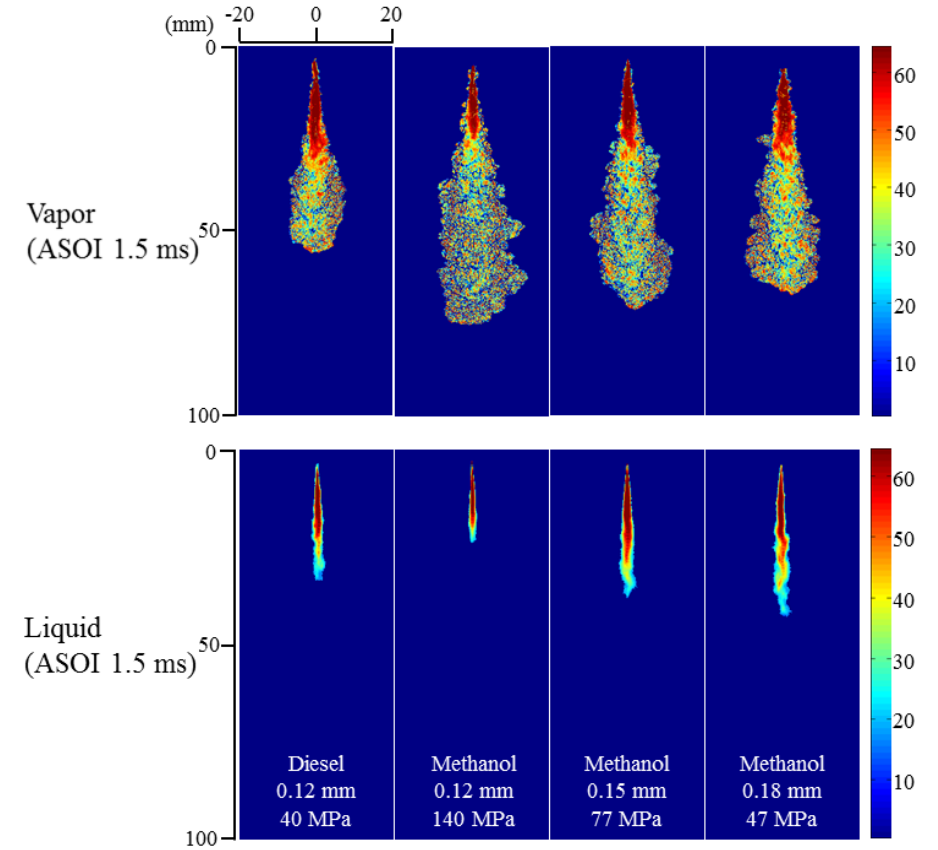
Figure 13. Comparison results of typical evaporating spray images under different strategies. The time-resolved spray parameters are quantitively plotted in Figure 14. The high pressure or the large nozzle hole makes the spray tip penetration, spray angle and spray area of the vapor phase methanol spray significantly larger than those of the diesel spray at the same timing during the same injection duration. When the hole diameter is 0.12 mm, since the injection volume of methanol is more than twice that of diesel, in order to ensure the same injection duration, the injection pressure of methanol should be increased to 140 MPa, and the spray penetration is about 20 mm longer than that of the diesel spray. With the decrease in injection pressure, the methanol spray penetrates a shorter distance. When the nozzle hole diameter of methanol is 0.18 mm, the injection pressure can be comparable to that of diesel. However, since the cross-sectional area of the nozzle hole of methanol is more than twice that of diesel, the spray penetration distance is still longer than that of diesel by about 15 mm. From the perspective of the methanol spray alone, with the decrease in the injection pressure, the spray penetration should decrease, but the momentum loss is not so great due to the increase in the nozzle hole diameter. As a result, the final spray tip penetration does not drop by much. With the decrease in injection pressure, the spray angle of methanol is apparently decreased. However, affected by the increasing hole diameter, the spray angle of methanol is also larger than that of diesel under the three conditions, but the deviation drops from 3.8 deg to 2.5 deg. The integrated effect of the spray tip penetration and spray angle results leads the spray area results to present the same trend as those of the spray penetration. When the nozzle diameter of methanol is 0.18 mm, the spray area develops to be 72% larger than that of